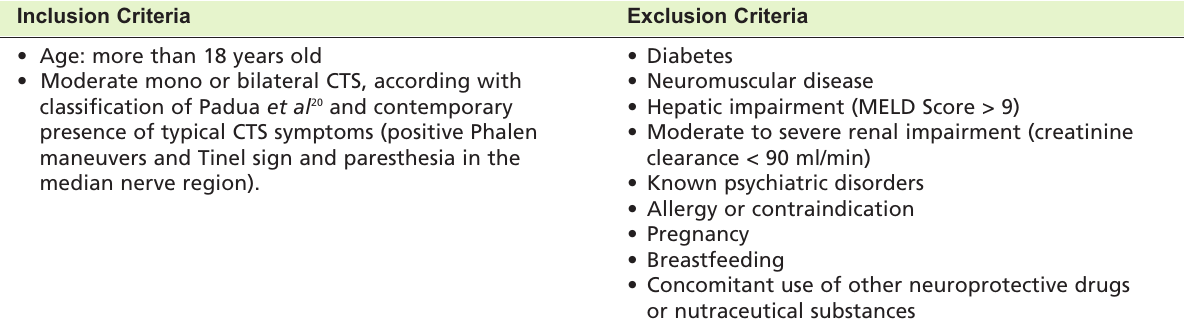
Inclusion/exclusion criteria Table I: